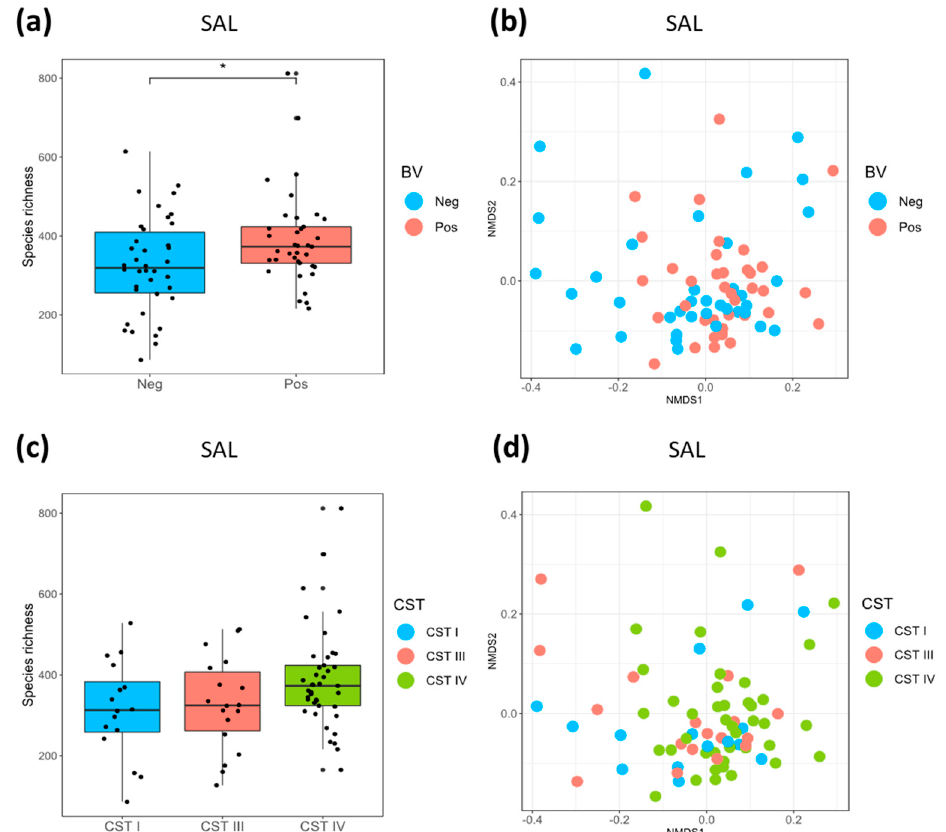
Figure 3. Species richness and beta diversity of saliva samples by BV status and CST. Boxplots showing species richness measured using Chao1 of saliva (SAL) samples according to ( a ) bacterial vaginosis (BV) status (Neg = deepskyblue, Pos = salmon) and ( c ) vaginal community state type (CST) (CST-I = blue, CST-III = salmon, CST-IV = green). Non-metric Multi-dimensional Scaling (NMDS) plots showing beta diversity of saliva (SAL) (N = 75) samples calculated using unweighted-Unifrac distances according to ( b ) BV status and ( d ) vaginal CSTs.